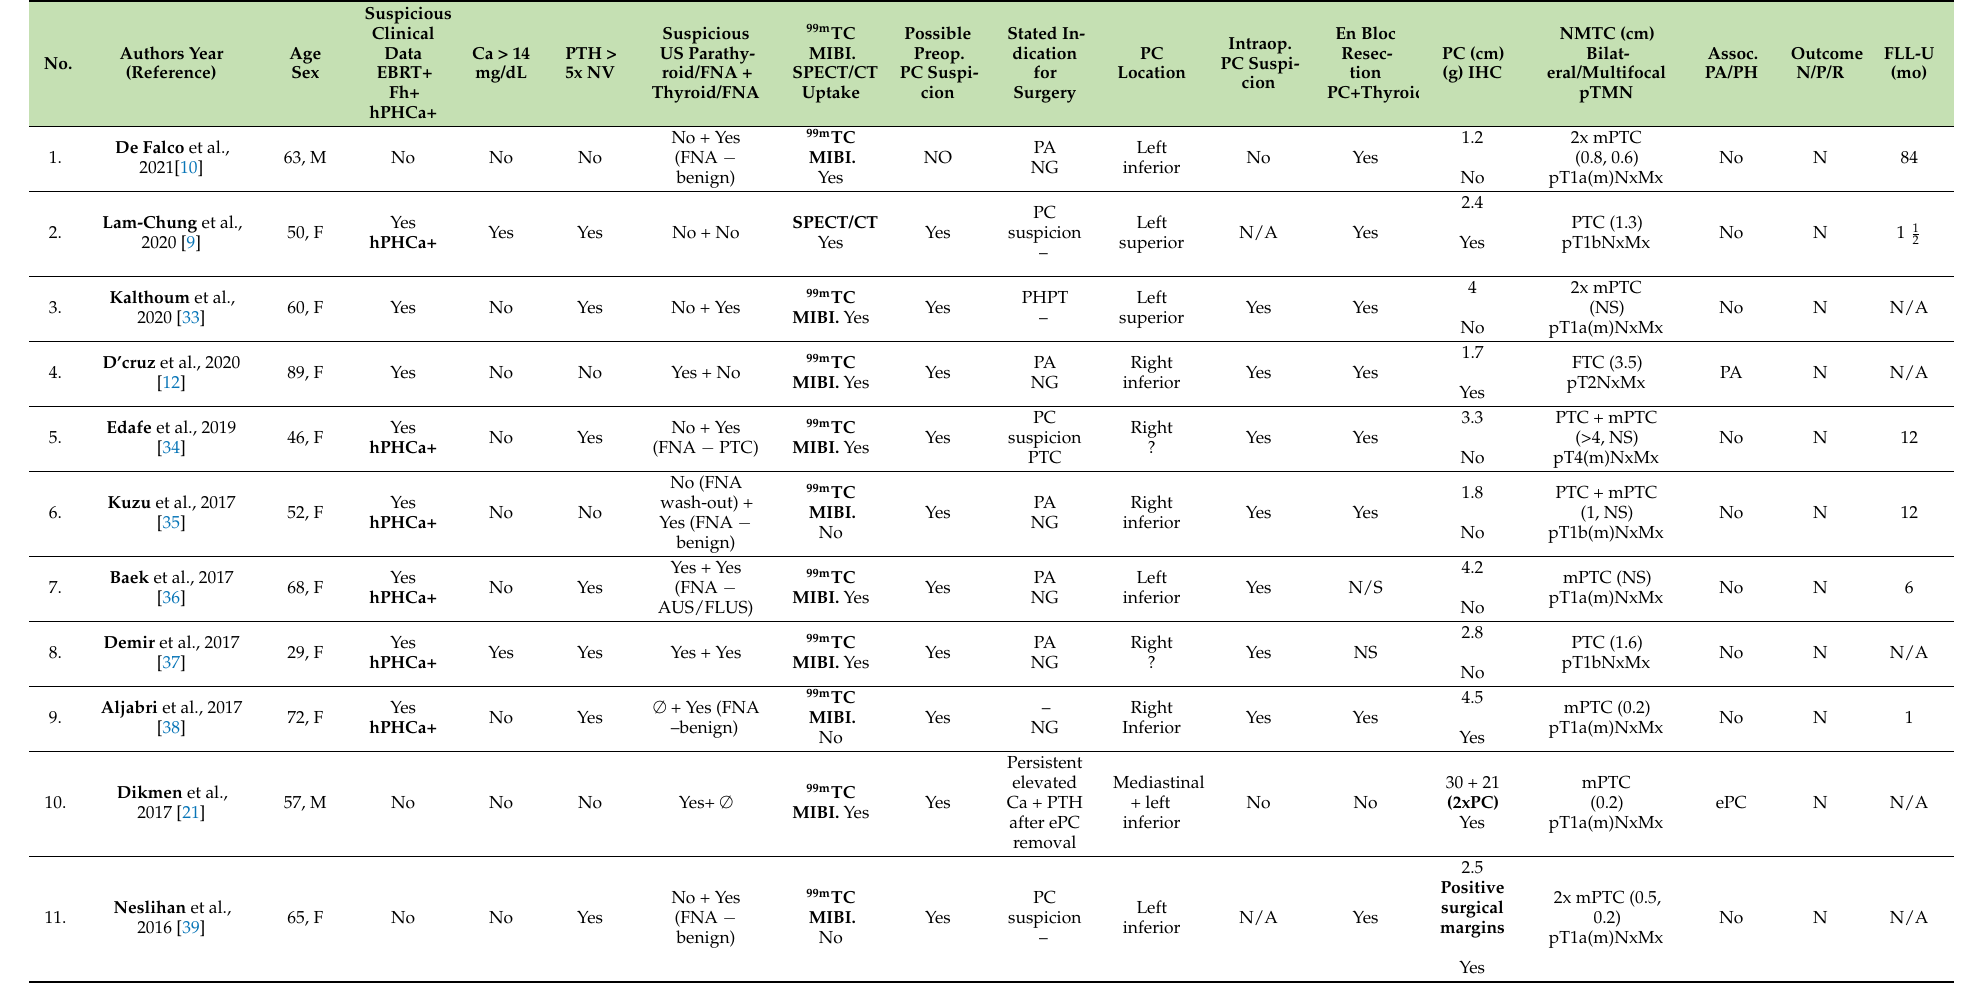
Table 1. Features of patients with synchronous parathyroid and differentiated thyroid